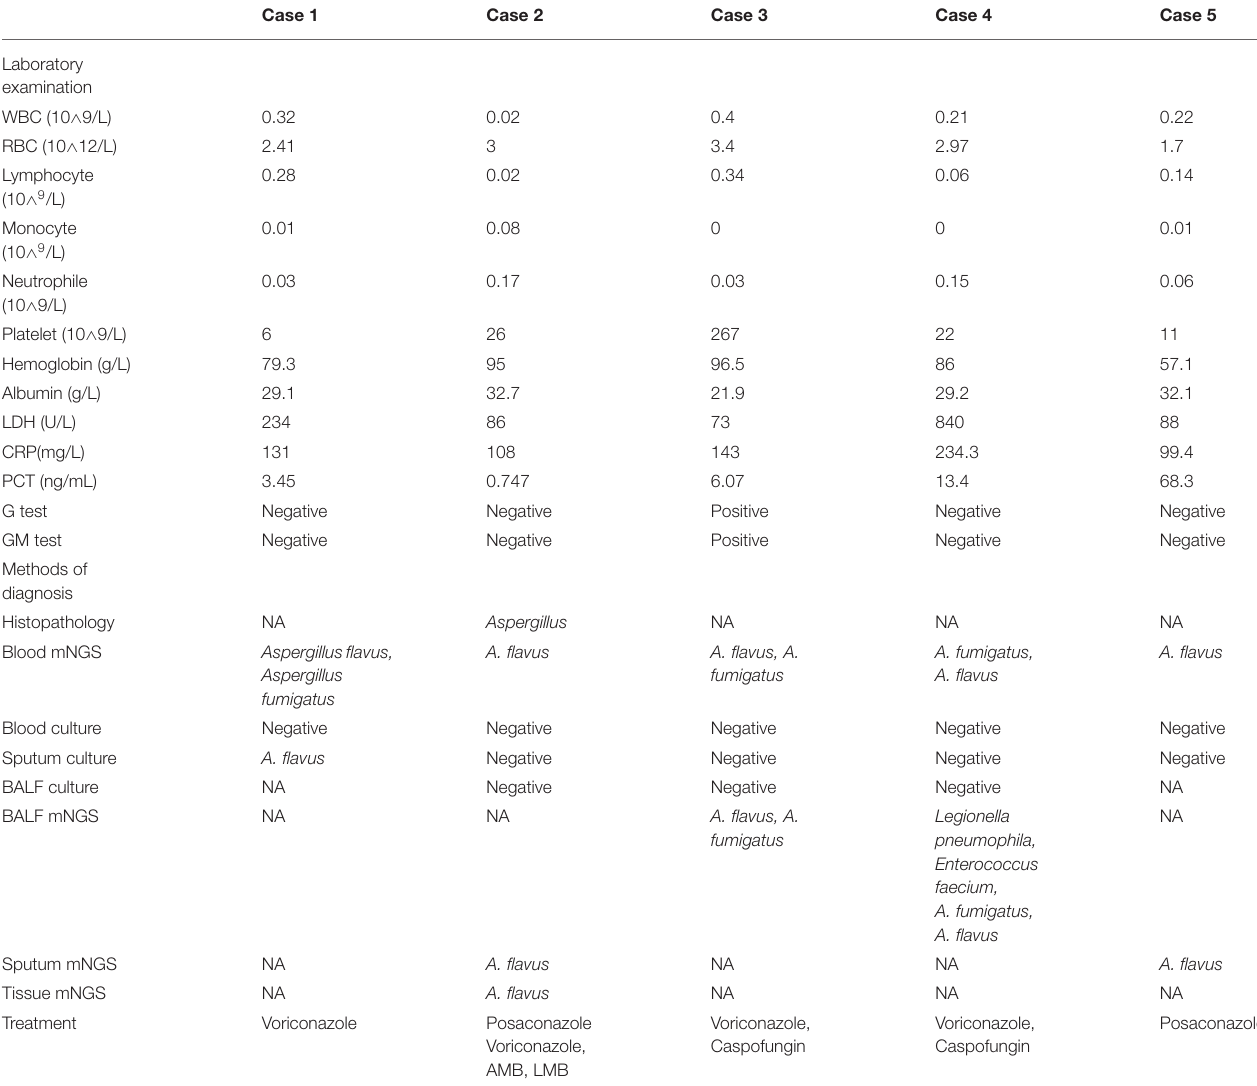
TABLE 2 | Laboratory examination and